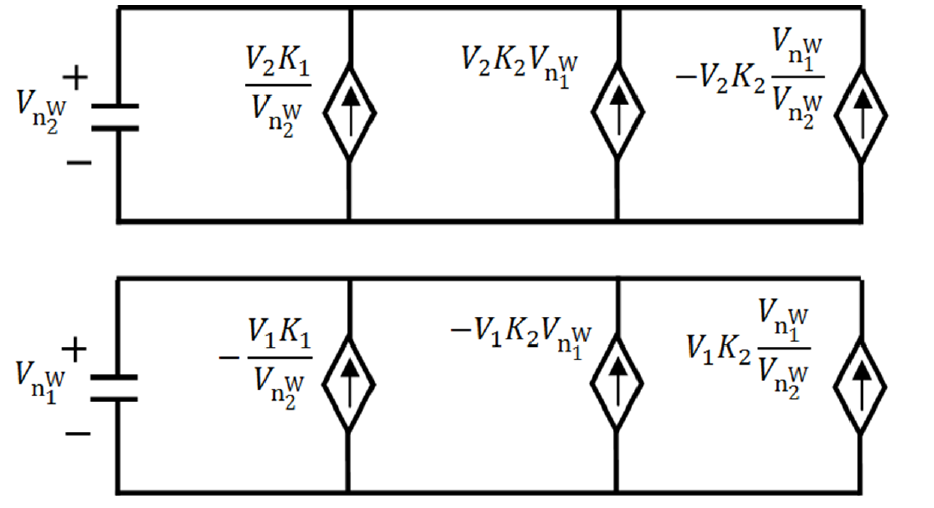
Figure 15. The analogous electrical circuit of number of moles (cid:1866) (cid:2869)(cid:3050) and (cid:1866) (cid:2870)(cid:3050) that are related to the osmosis system